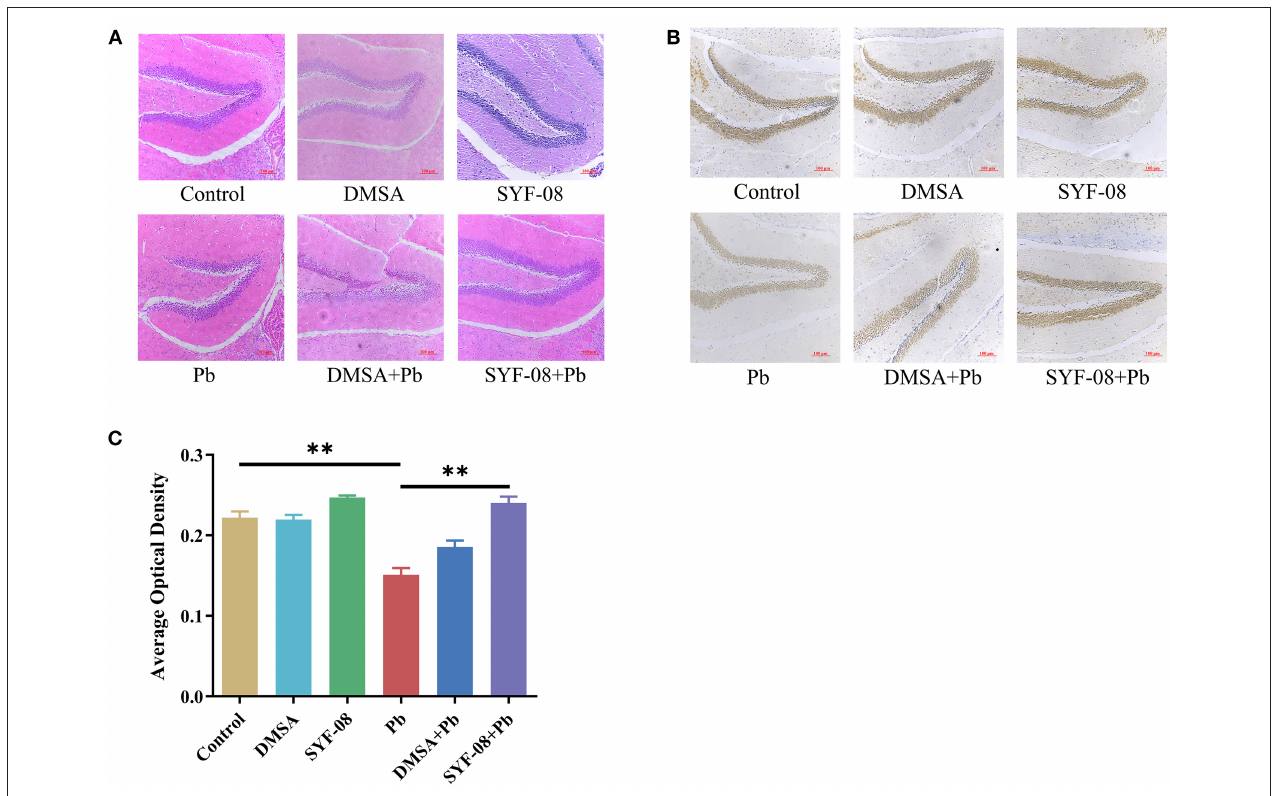
FIGURE 3 | Lactobacillus casei SYF-08 protects against Pb-induced brain injury. (A) Representative HE staining of brain in the different groups (200 × ). (B) Representative IHC staining of NeuN-positive cells in the different groups (200 × ). (C) Avergae optical density of IHC staining. ** P <